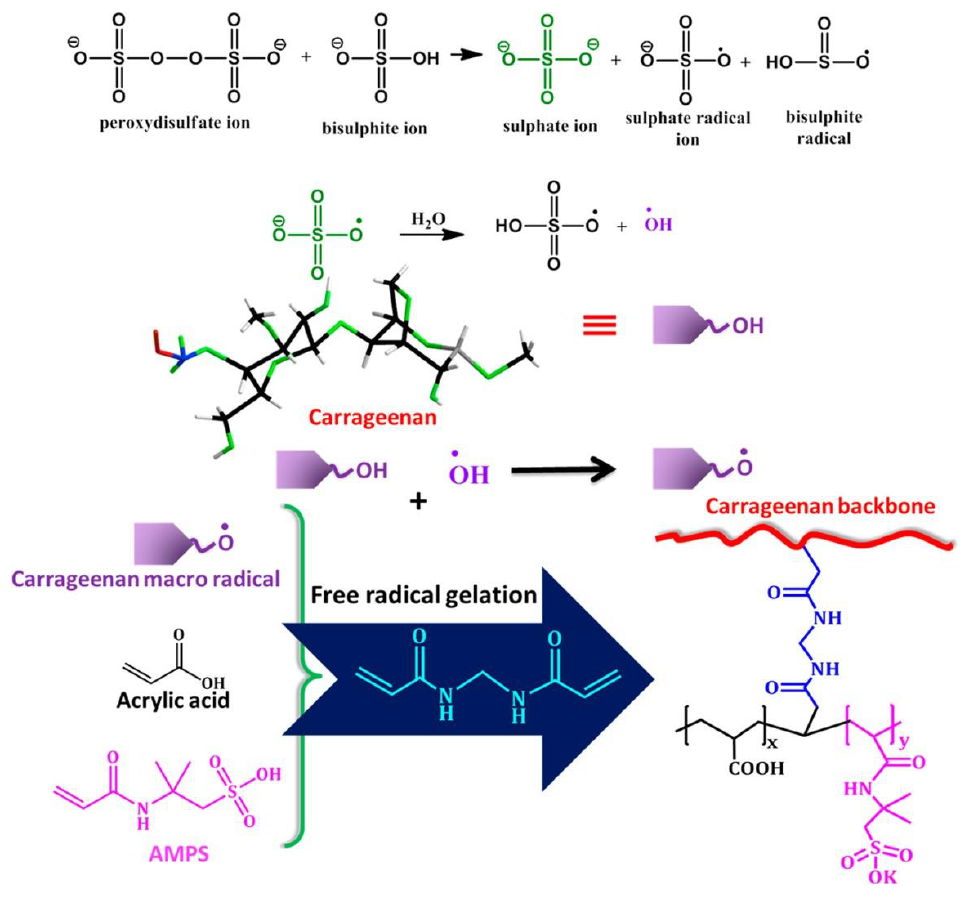
Figure 5. Schematic illustration of redox imitator assisted gelation. Reproduced with the permission of [108] , Copyright 2018 American Chemical Society.